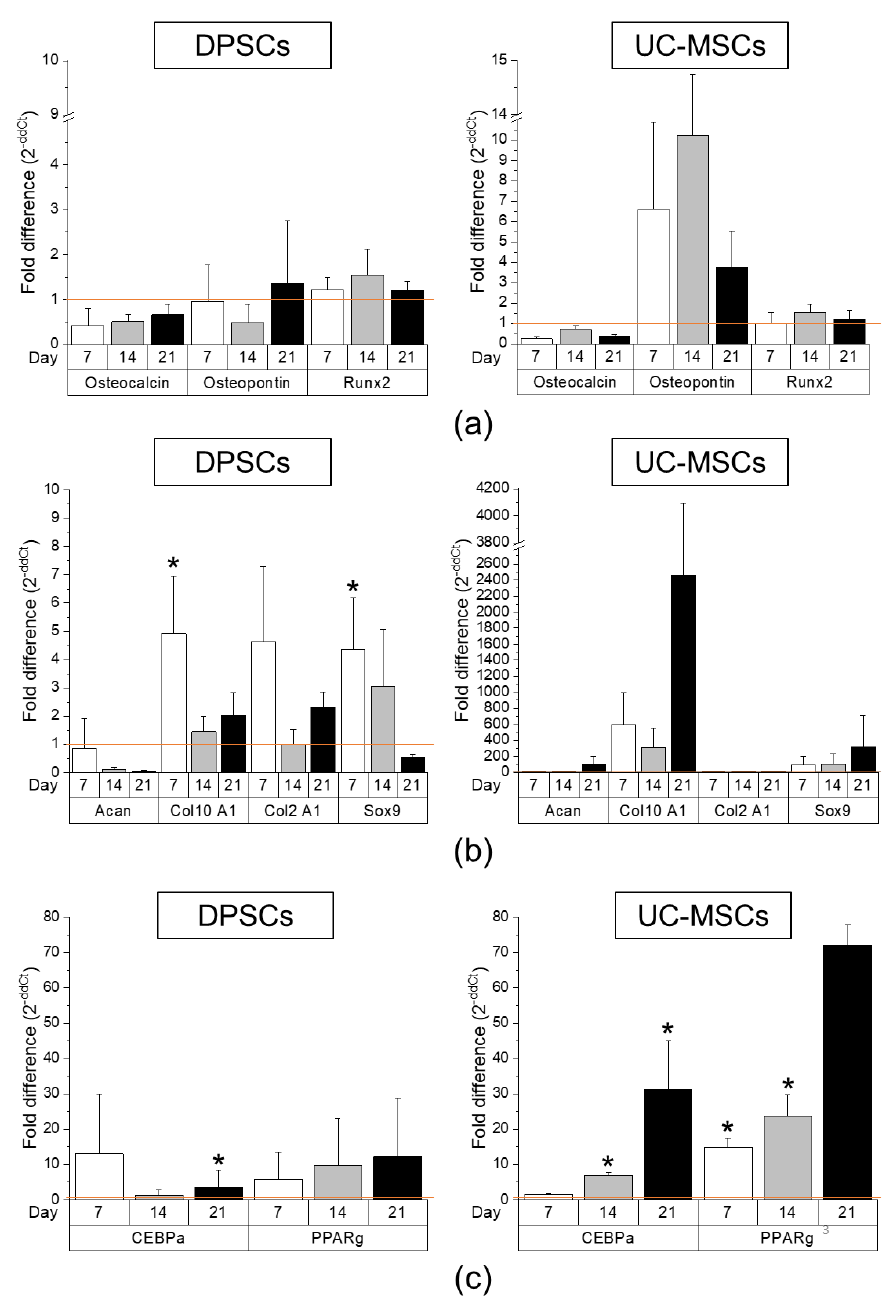
Figure 3. Comparison of tri-lineage differentiation potential of DPSCs and UC-MSCs by real-time RT-PCR. ( a ) Quantitative analysis of mRNA expression for osteogenesis related genes (osteocalcin, osteopontin, Runx2 ) in DPSCs (left) and UC-MSCs (right). ( b ) Quantitative analysis of mRNA expression for chondrogenesis related genes ( Acan, Col10A1, Col2A1, Sox9 ) in DPSCs (left) and UC-MSCs (right). ( c ) Quantitative analysis of mRNA expression for adipogenesis related genes ( CEBPα, PPARγ ) in DPSCs (left) and UC-MSCs (right). Cells were cultured in a StemPro osteogenesis differentiation kit, StemPro chondrogenesis differentiation kit, and StemPro adipogenesis differentiation kit for 7, 14, and 21 days, respectively. Fold differences in expression (2 −ddCt ) of analysed genes in control cells cultured in standard cell culture medium (undifferentiated) were calculated as 1.0 and marked by a solid line. Graphs present different scales. Results are presented as mean ± standard error of the mean (SEM), n = 3 (every sample prepared for each DPSCs line derived from each donor were run in duplicates); t -test, (*) p < 0.05 vs. undifferentiated cells.